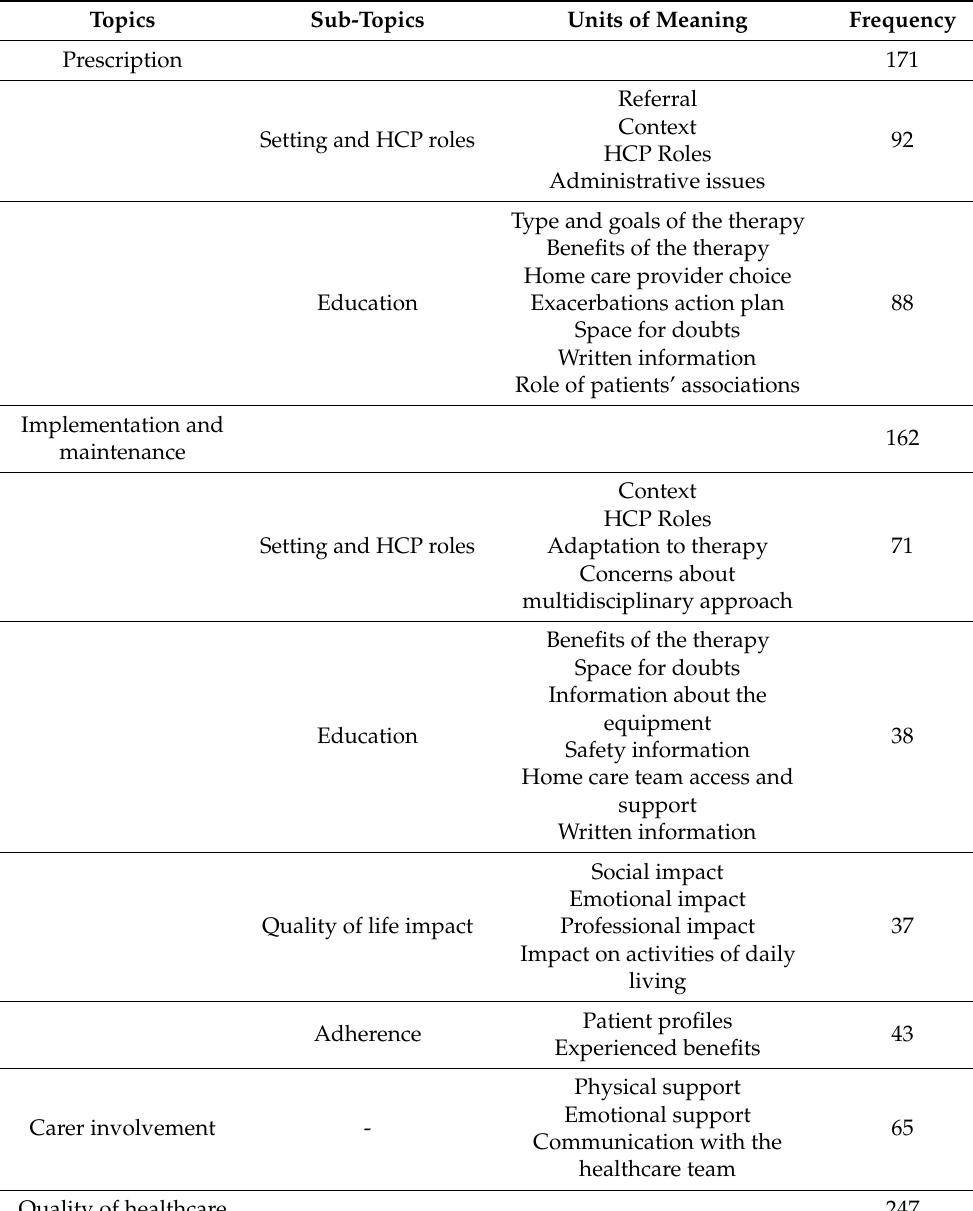
Table 2. Frequency in units of meaning of each identified topic and sub-topic during focus